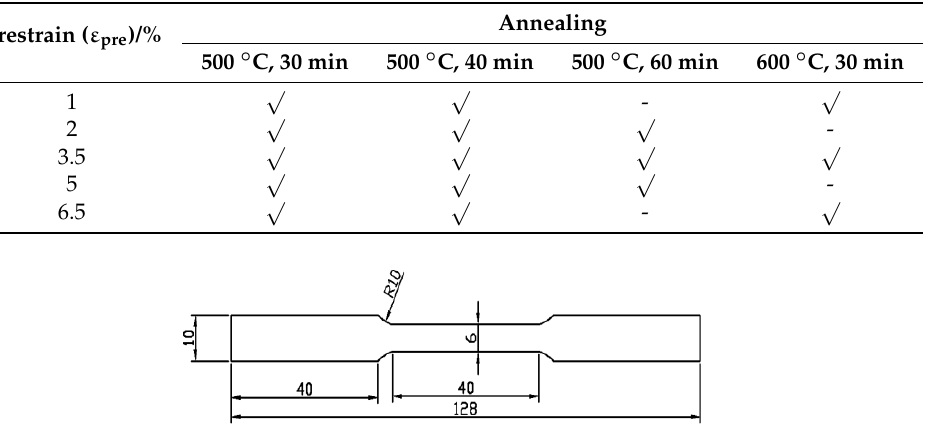
Figure 1. The geometry of the test specimens.